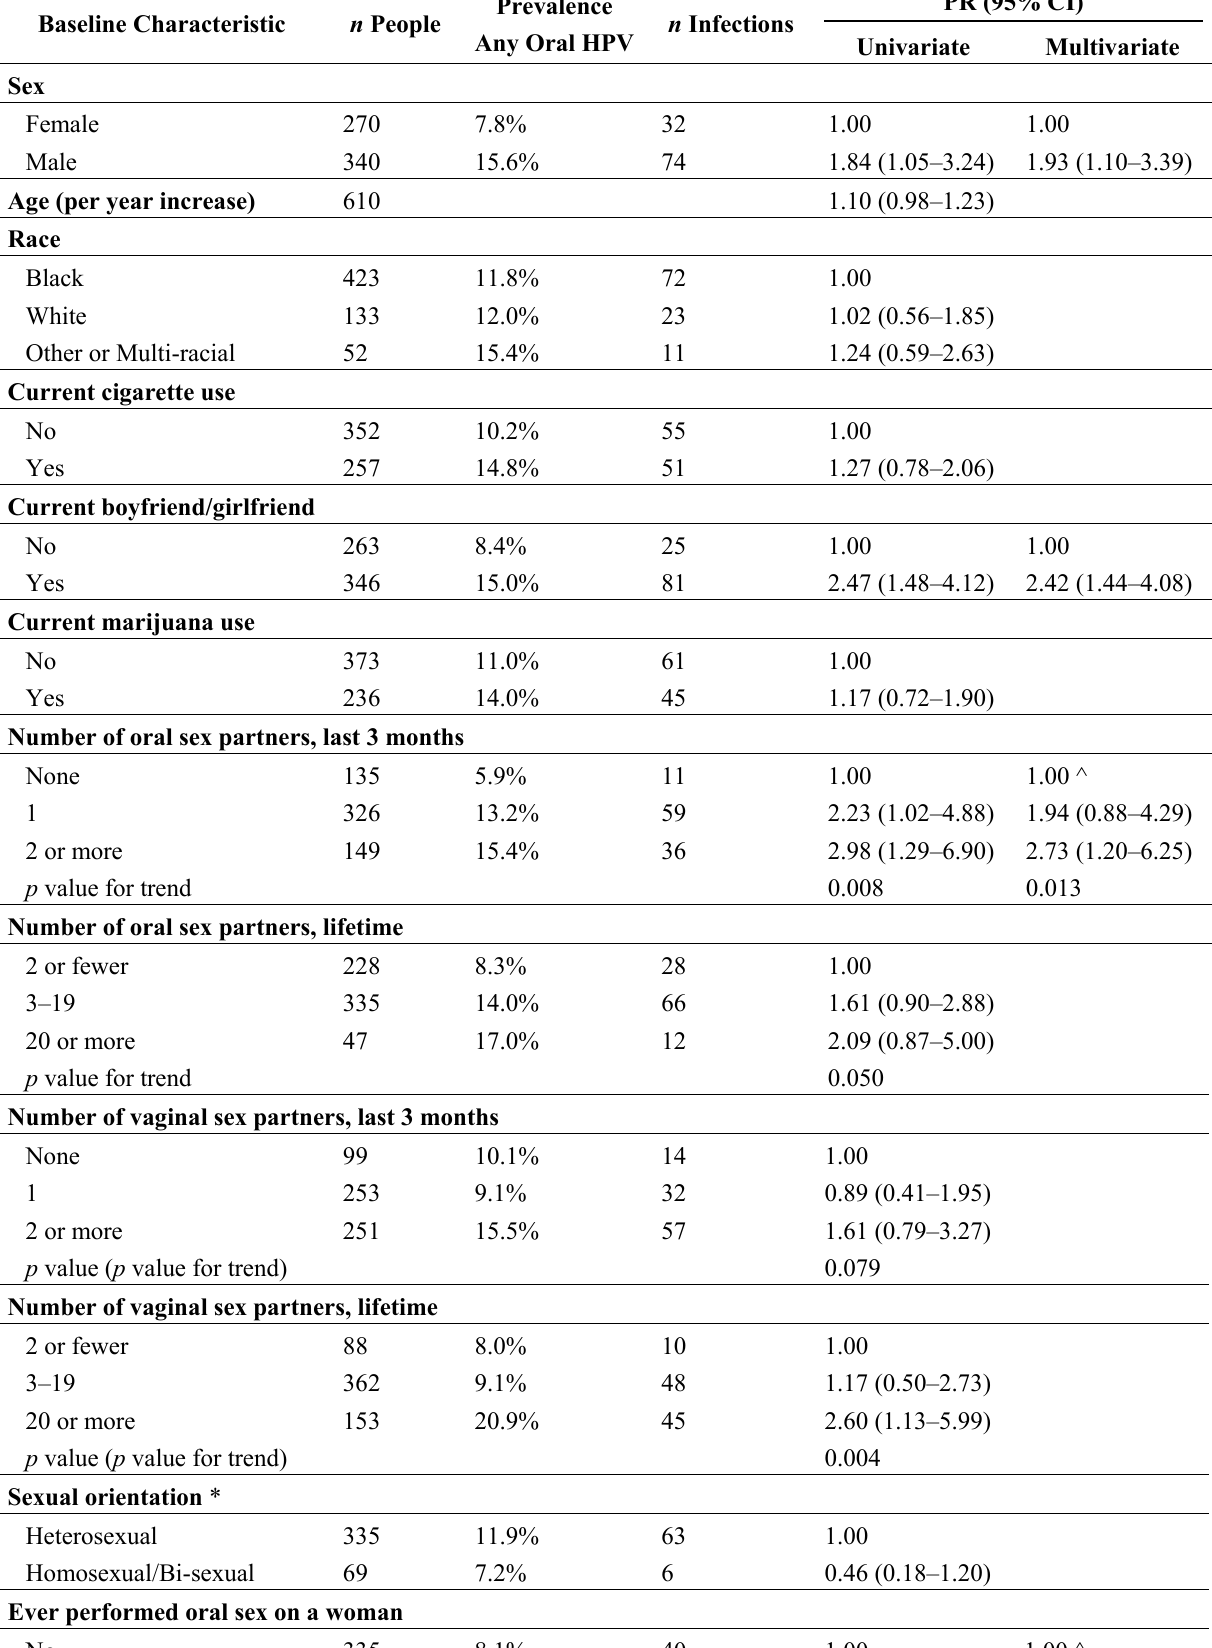
Table 4. Univariate and multivariate risk factors for prevalent oral HPV